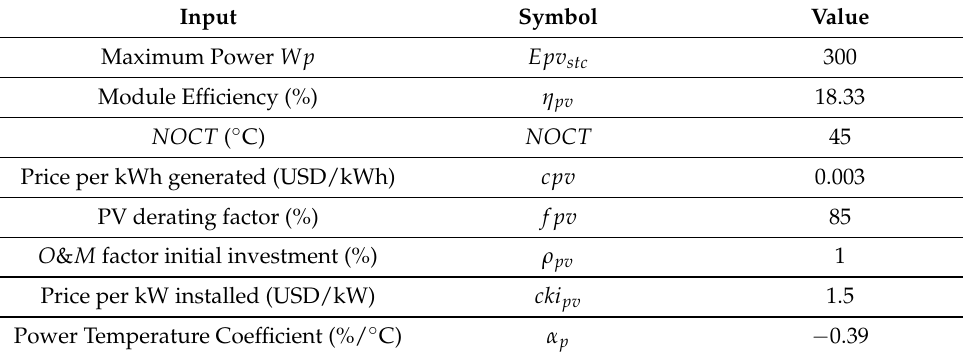
Table 2. Input parameters of the PV module.